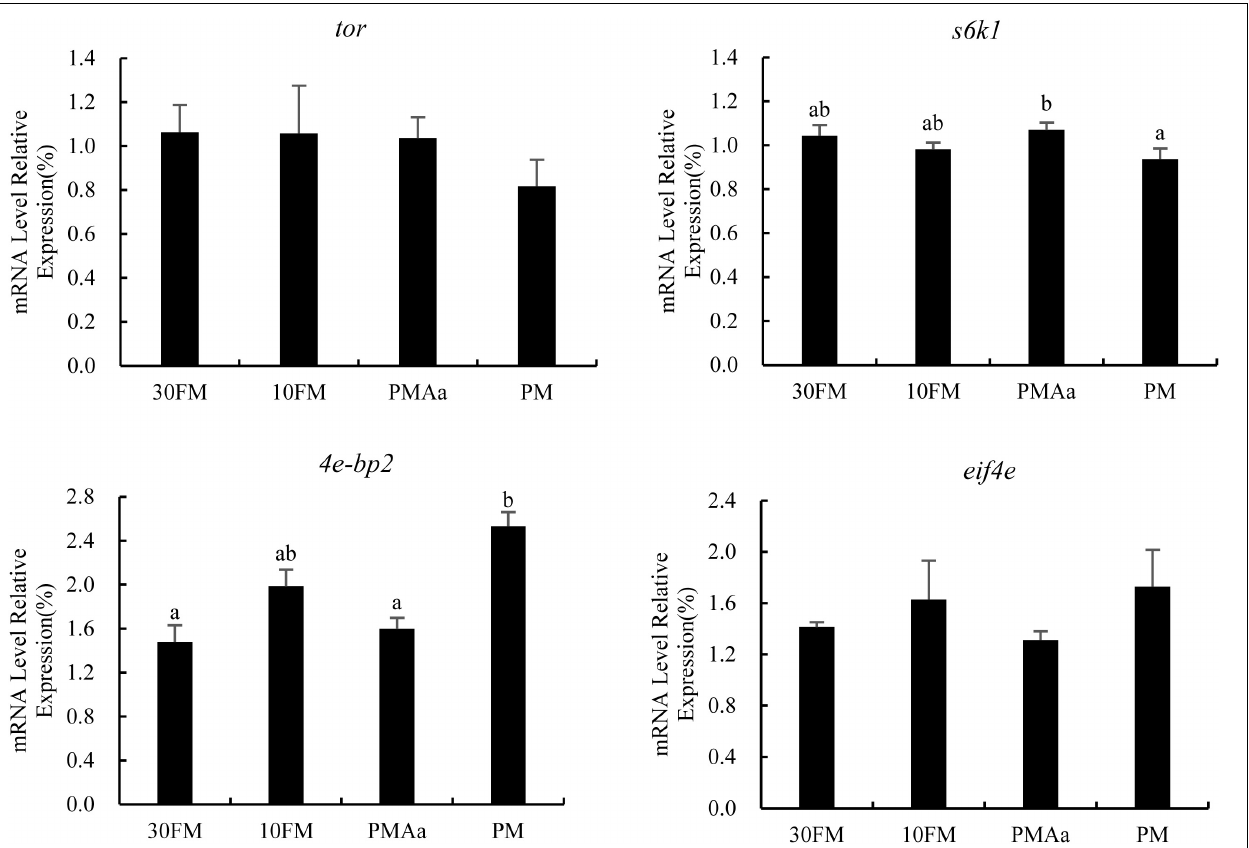
FIGURE 1 | Relative expression of protein synthesis genes ( tor , s6k1 , 4e-bp2 , and eif4e ) in the muscle of gibel carp β -actin and ef1 α was used as reference gene for the assessment of expression. Columns represent the mean ± SEM ( n = 6). For each index, bars without sharing a common letter indicate significant differences ( p <